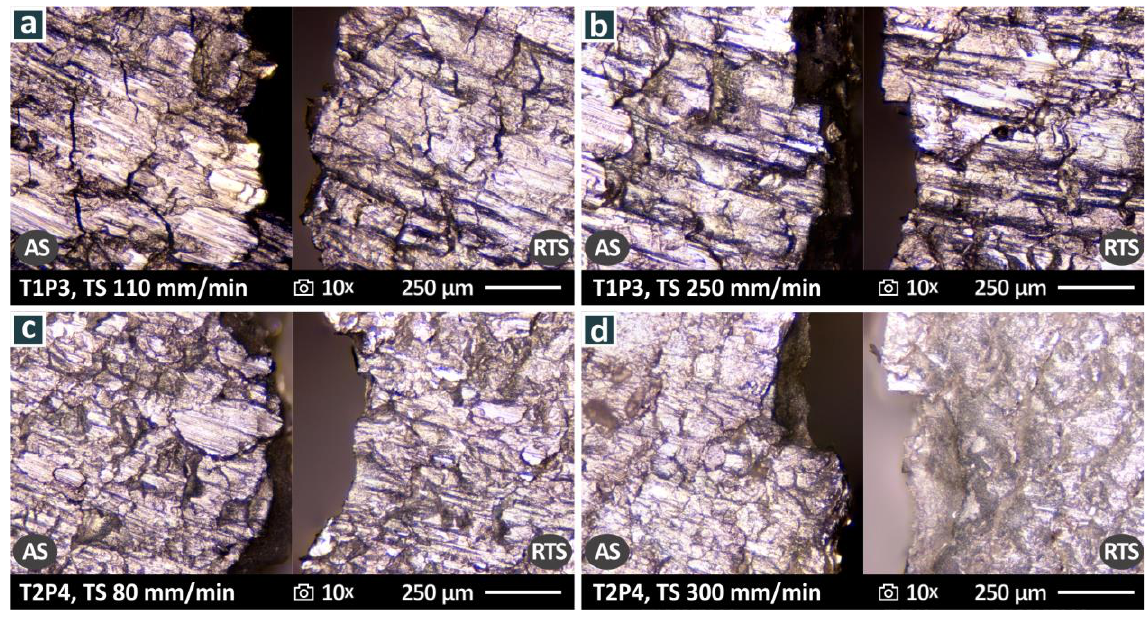
Figure 12. Higher magnification stereoscopic microscopy images for the T2P4 weld tool at weld speeds of 80 mm/min: ( a ) top surface, ( b ) fracture surface; and 300 mm/min: ( c ) top surface, ( d ) fracture surface.